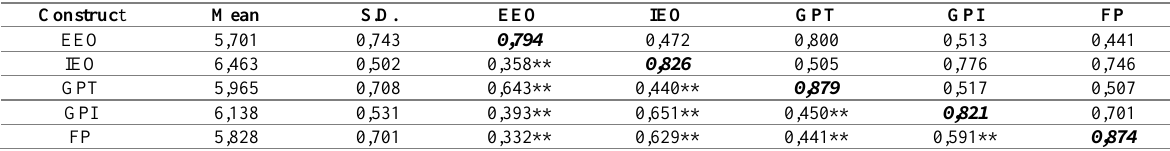
Table 2: Correlations and discriminant validity results. (n=315)